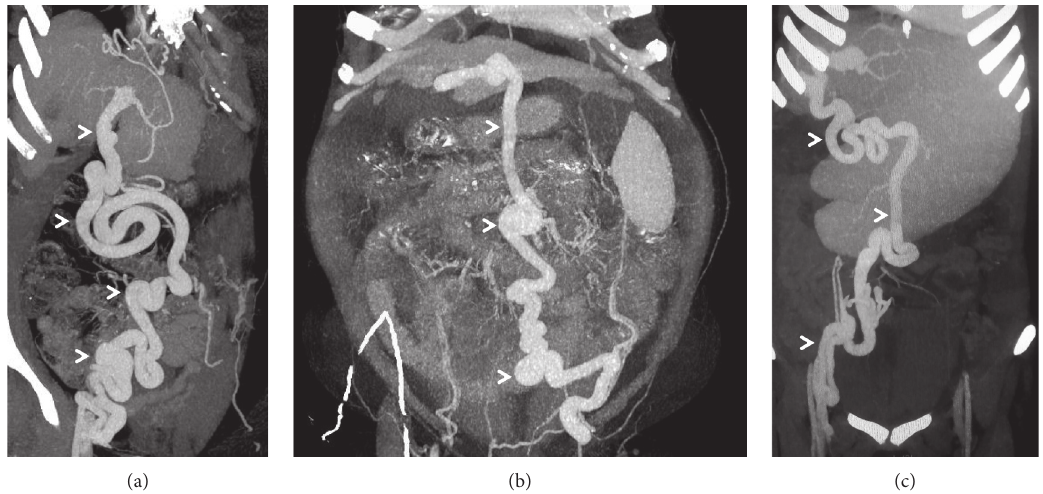
Figure 3: Coronal-oblique maximum intensity projection (MIP) CECTimages (a–c) from three different patients depicting the recanalised paraumbilical vein shunt (arrowheads).